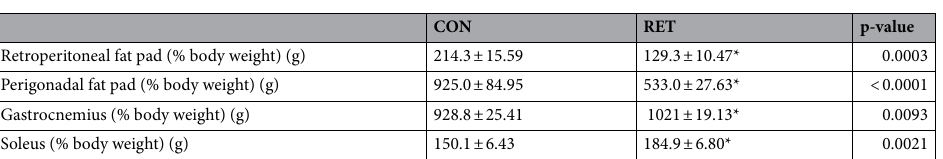
Table 1. Final characterization of Control (CON) and Resistance exercise training (RET) mice. (*) Indicates statistic differences between groups. Data are presented as the mean ± SEM, n = 10. Student’s t-test or Mann– Whitney